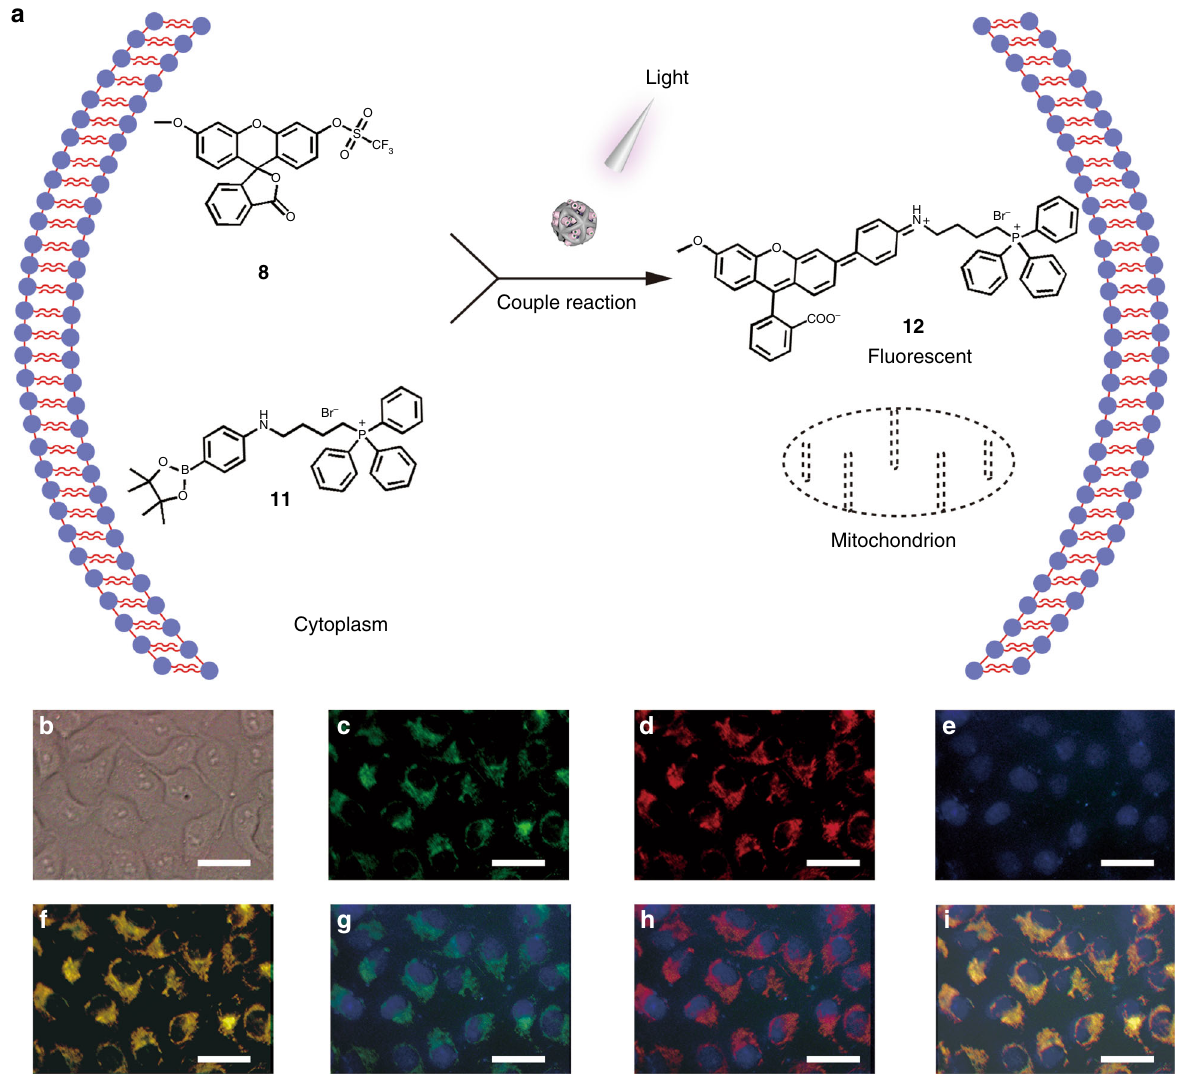
Fig. 4 Light-gated Suzuki – Miyaura coupling reaction. a Scheme of the light activation 10 of CASP catalyzed cross-coupling reaction generates the mitochondria-localized fl uorescent product 12 . b-i Collection of the fl uorescence images of the CASP catalyzing the Suzuki – Miyaura coupling reaction with the UV light activation: b bright- fi eld image of HeLa cells, c emission of the compound 12 (green channel), d the mitochondrion labeled with MitoTracker ® Red CMXRos (red channel), e the cell nucleus labeled with Hoechst 33258 (blue channel), f merging with c and d , g merging with c and e , h merging with d and e , i merging with c , d , and e (scale bar = 10 µ m). The low fl uorescence intensity of green channel indicated the low catalytic activity of CASP as we